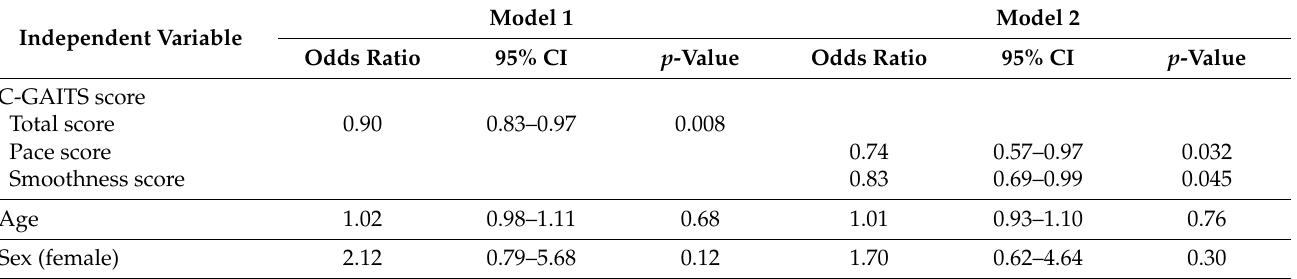
Table 3. Odds ratio for elevated degree of pain after daily walking in multiple logistic regression